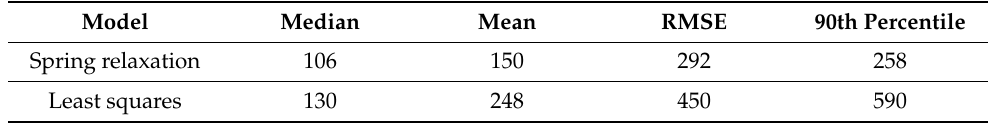
Table 5. Accuracy of the model-based methods after being retrained on the entire 80% training set and tested on the 20% test set. The RMSE for both is greater than the 90th percentile errors, indicating that there are some large errors. All values are in